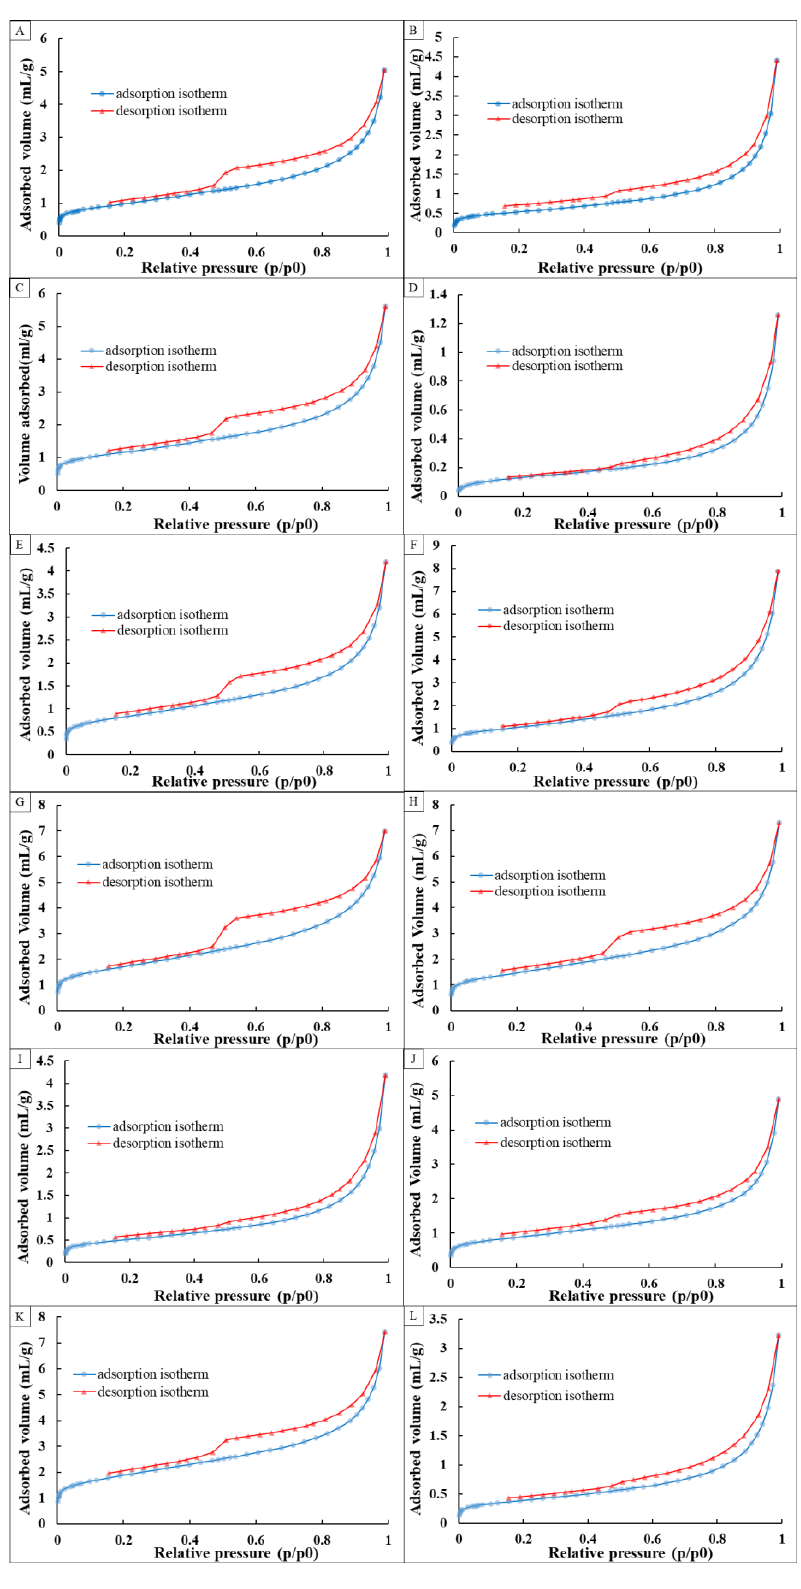
Figure 5. Nitrogen adsorption and desorption isotherms of shale samples from the Taiyuan Formation in the study area: ( A ) LX1-1, ( B ) LX1-2, ( C ) LX1-3, ( D ) LX2-1, ( E ) LX3-1, ( F ) LX4-1, ( G ) LX5-1, ( H ) LX5-2, ( I ) LX6-1, ( J ) LX7-1, ( K ) LX7-2, and ( L )